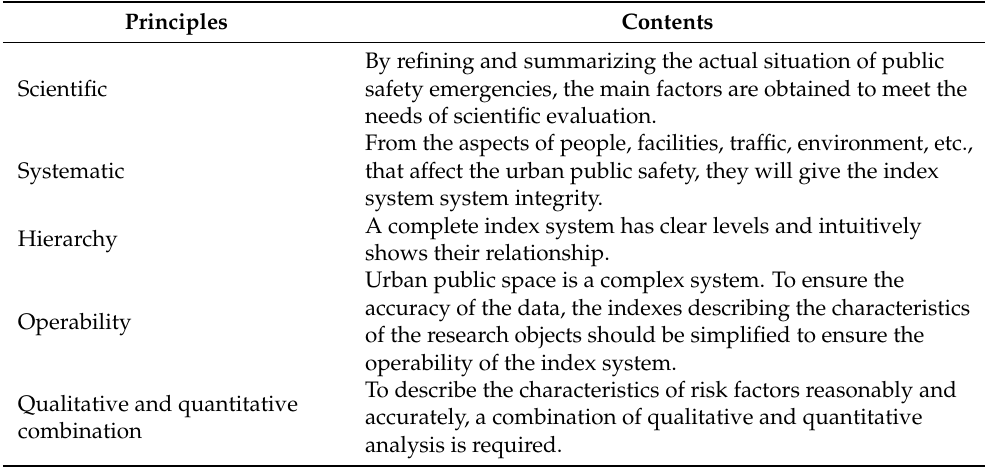
Table 1. Principles of constructing index system.